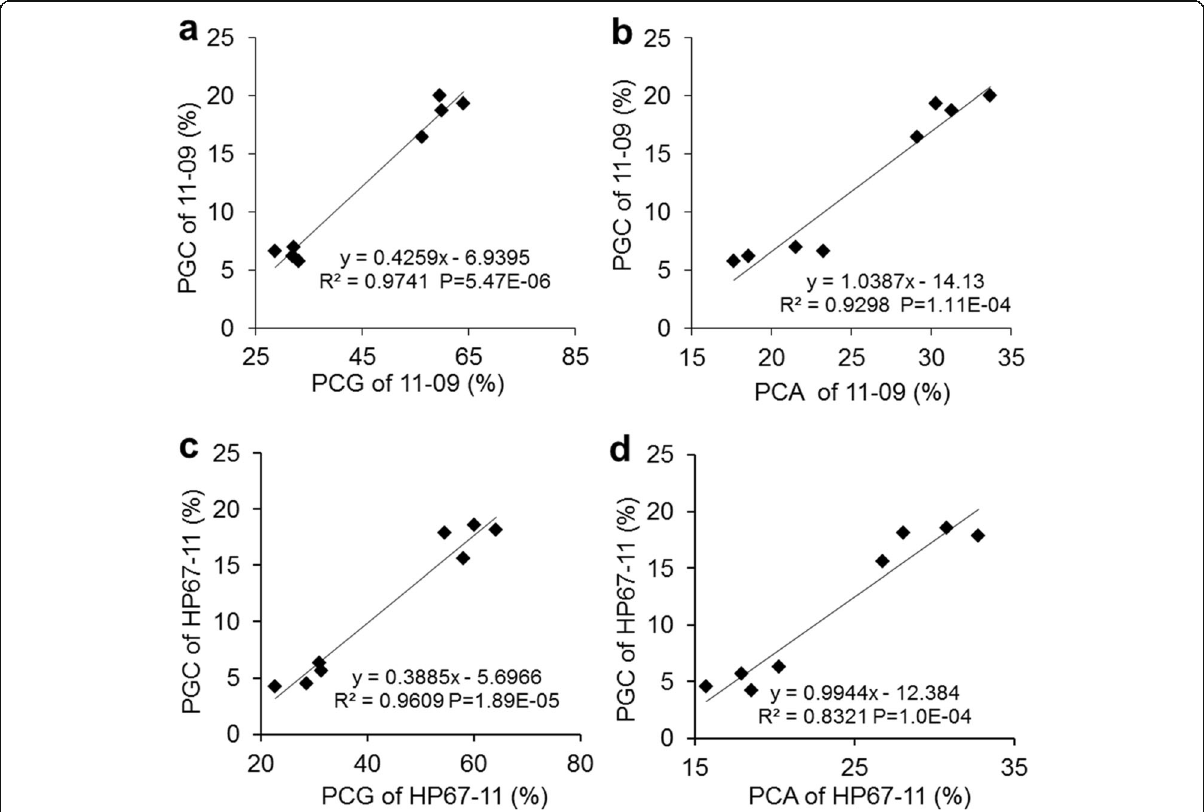
Fig. 4 Regression correlation analysis between PCG and PGC and between PCA and PGC of SSSLs 11 – 09 and HP67 – 11 . R 2 represents the